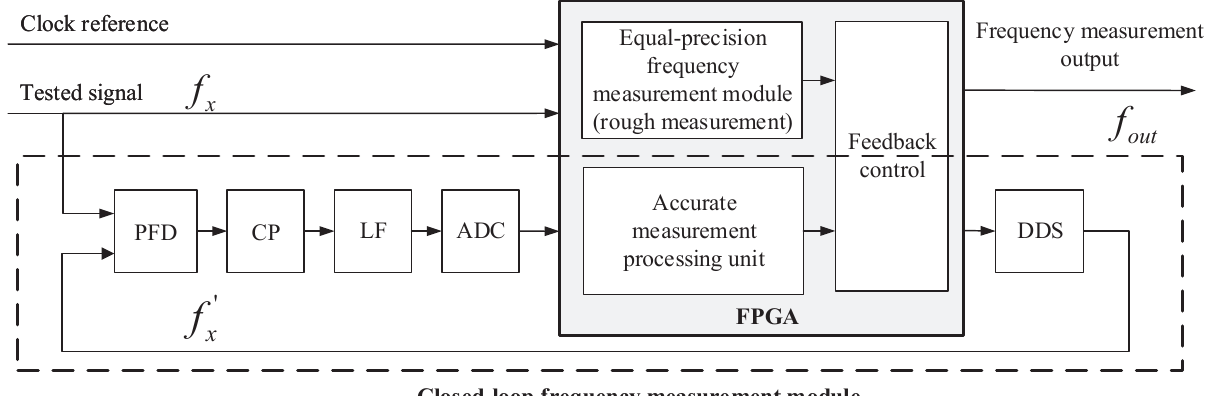
Figure 1. Overall structure diagram of the high-precision frequency measurement system based on negative feedback